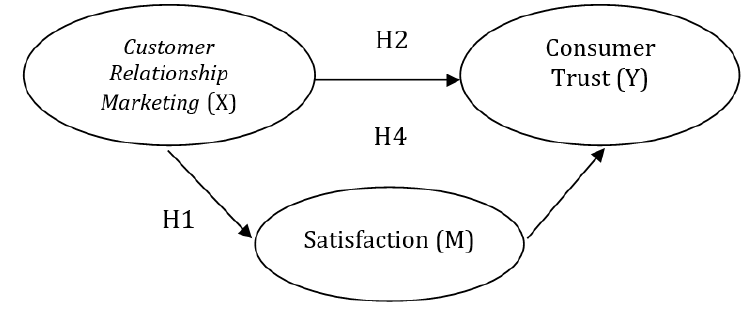
Figure 1: Framework of the Role of Satisfaction Mediates the influence of CRM (Customer Relationship Marketing) on Consumer Trust at Elite Sang Tunas Kid Courses Denpasar